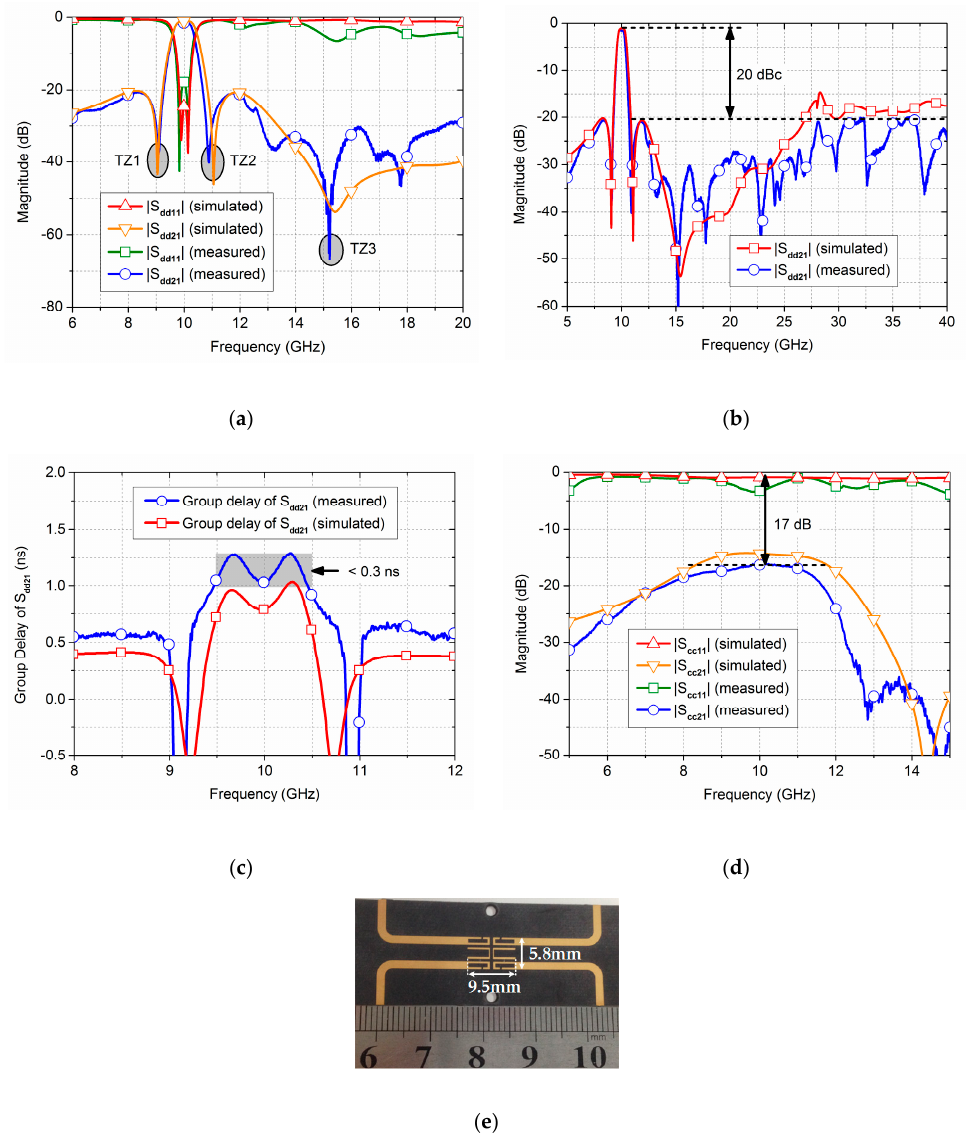
Figure 10. Measured results and photograph of the fabricated balanced filter: ( a ) |S21| and |S11| under differential mode (DM) operation; ( b ) wideband response of |S21| under DM operation; ( c ) |S21| and |S11| under CM operation; ( d ) measured group delay of S21 under DM operation; ( e ) photograph.